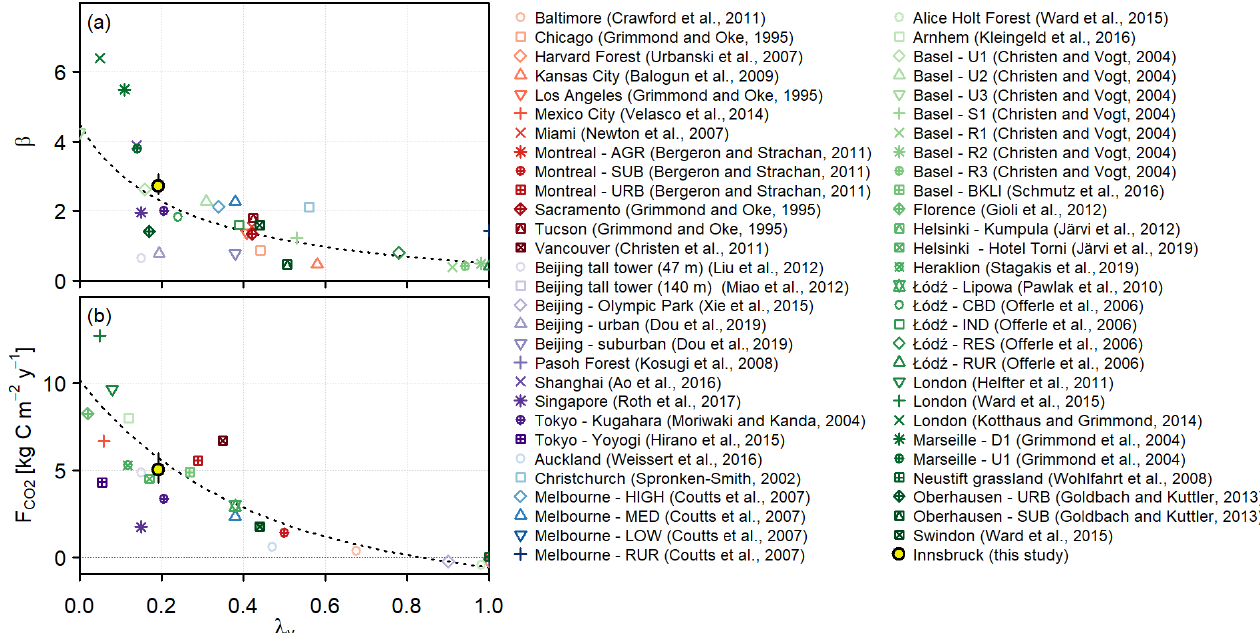
Figure 14. (a) Daytime or midday (depending on which is given in the corresponding publication) Bowen ratio during summer and (b) annual net carbon flux versus vegetation fraction λ v for IAO and for various sites in the literature (see the legend for references). Error bars for IAO indicate the spread of (a) daytime summertime values for the different years and (b) annual totals over the four 12-month periods of the dataset. The dotted lines in panel (a) are Eq. (3) from Christen and Vogt (2004) and in panel (b) from Nordbo et al.